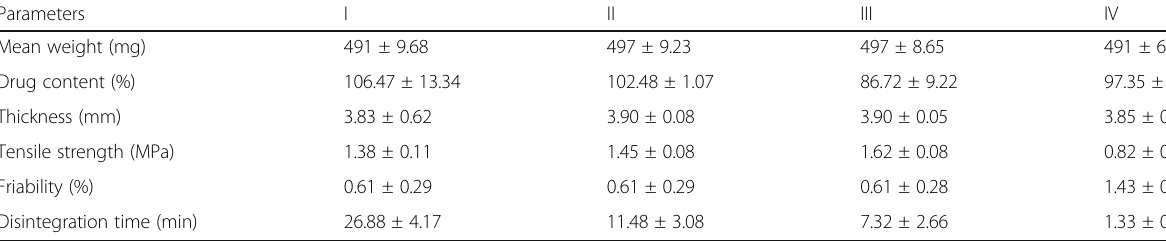
Table 3 Tableting properties of formulations I – IV